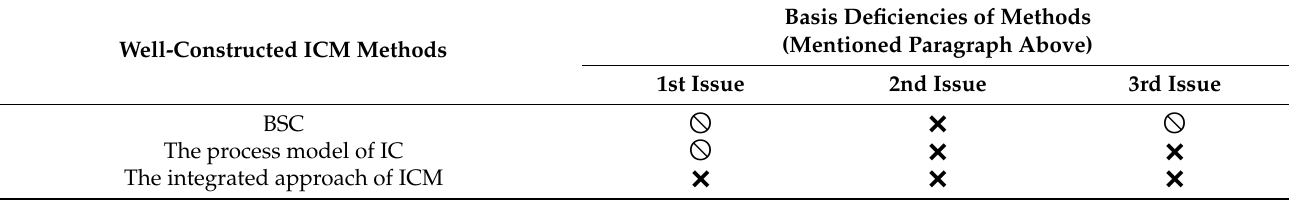
Table 1. Deficiencies of ICM methods.